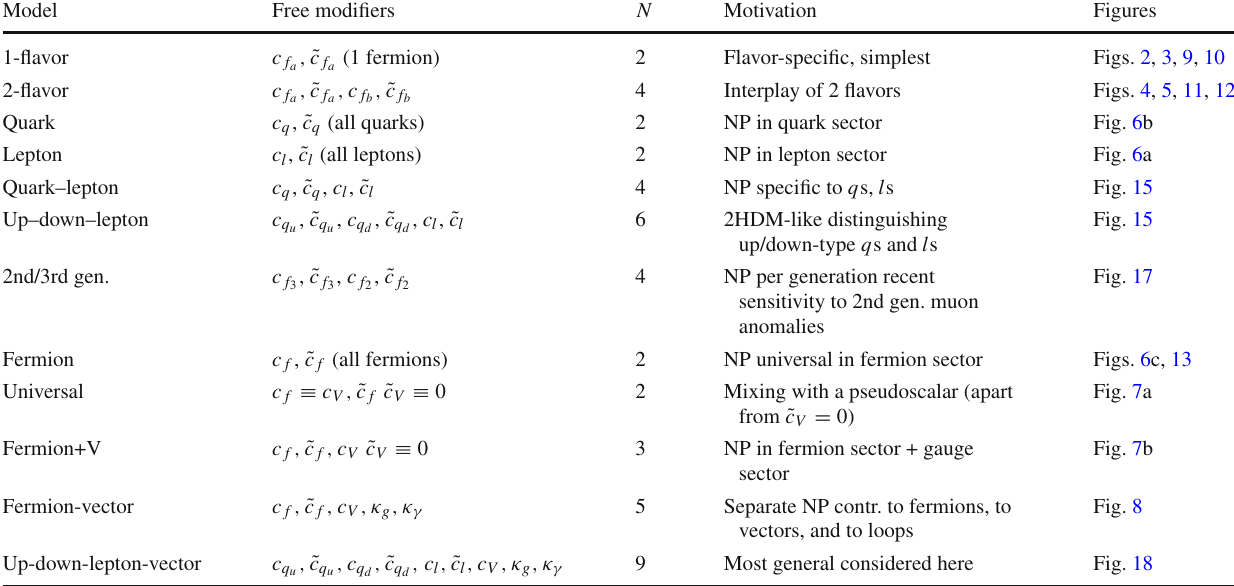
Table 1 Sets of coupling modifiers that are floated simultaneously. Coupling modifiers that are not listed in the second column are fixed to the SM values, c X = 1, ˜ c X = 0. The notation of the fermion cou- pling modifiers is described in the text. The vector coupling modifier is denoted as c V with V = W , Z , whereas κ g and κ γ are given by Eqs. (5) and (6) unless they are listed as free parameters in the second col-